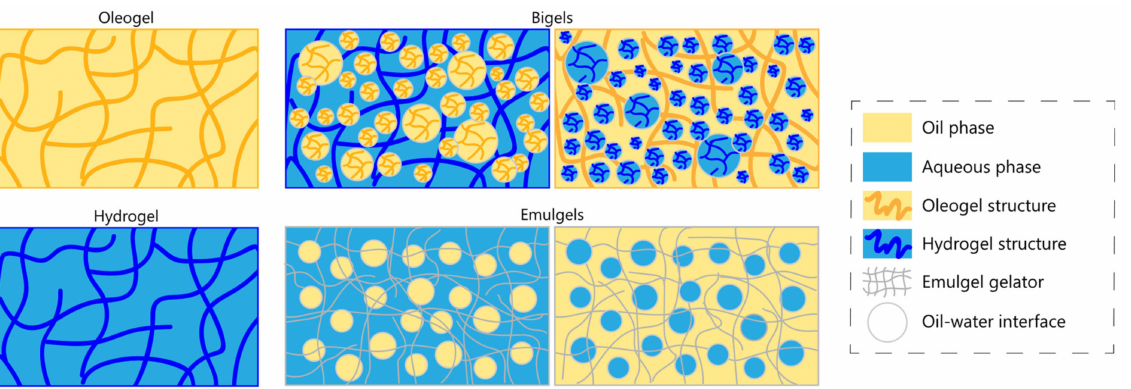
Figure 1. Schematic representation of oleogels, hydrogels, bigels, and emulgels structures. Organogels are semi-rigid formulations considered bicontinuous systems, comprising two phases: the gelator and the organic solvent (Figure 1). The gelator, when used in the formulation of organogels in concentrations of <15%, may experience physical and chemical transformations that create self-assembled structures; these structures